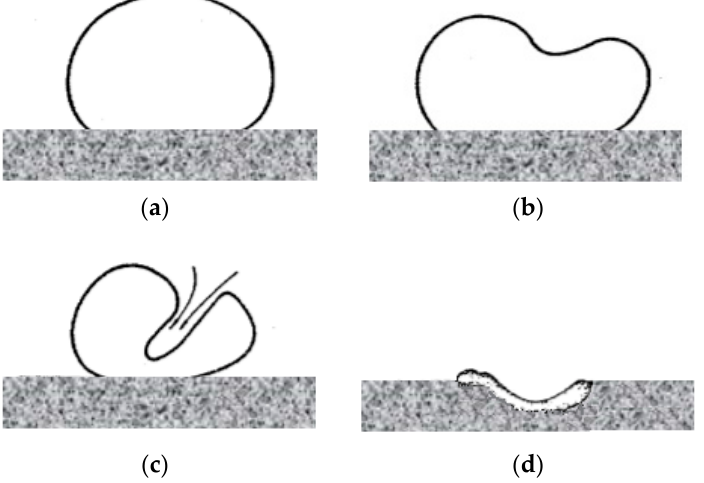
Figure 9. Mechanism of cavitation bubble collapse. ( a ) Initial bubble; ( b ) Initiation of bubble col- lapse; ( c ) Formation of liquid jet; ( d ) Impact and metal extrusion. ( c ) Formation of liquid jet; ( d ) Impact and metal